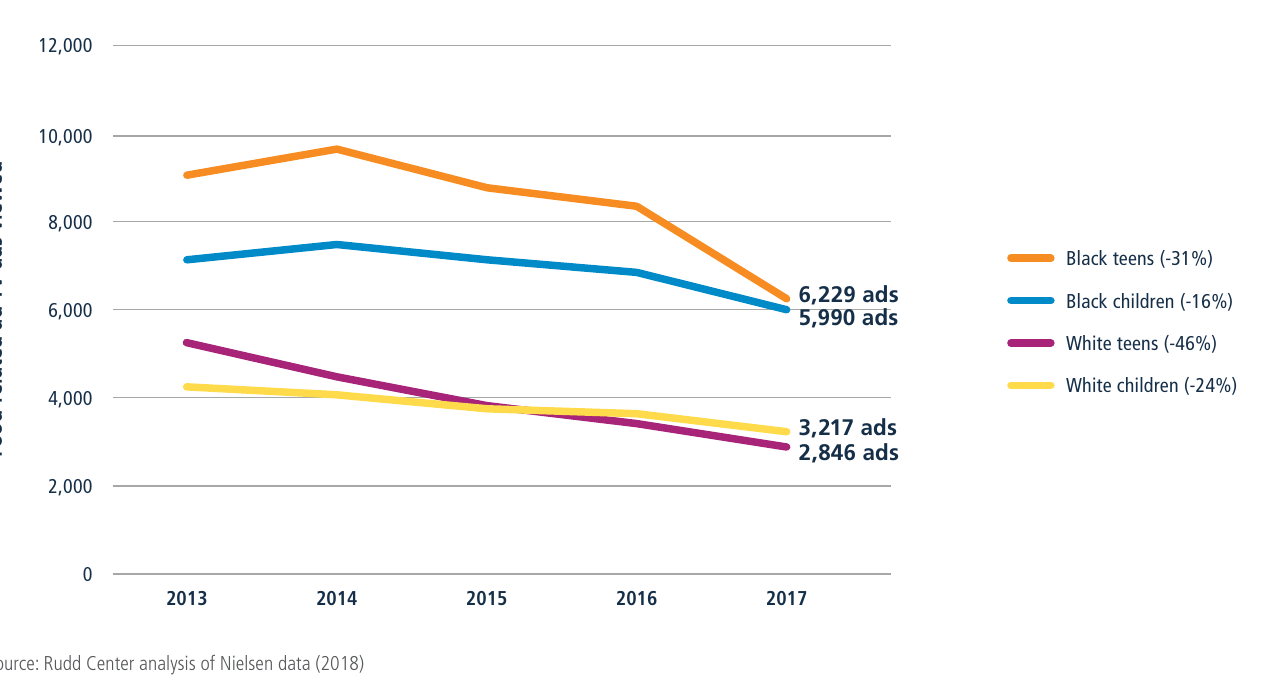
FIGURE 2. CHANGES IN FOOD-RELATED TV AD EXPOSURE FOR BLACK AND WHITE CHILDREN AND TEENS